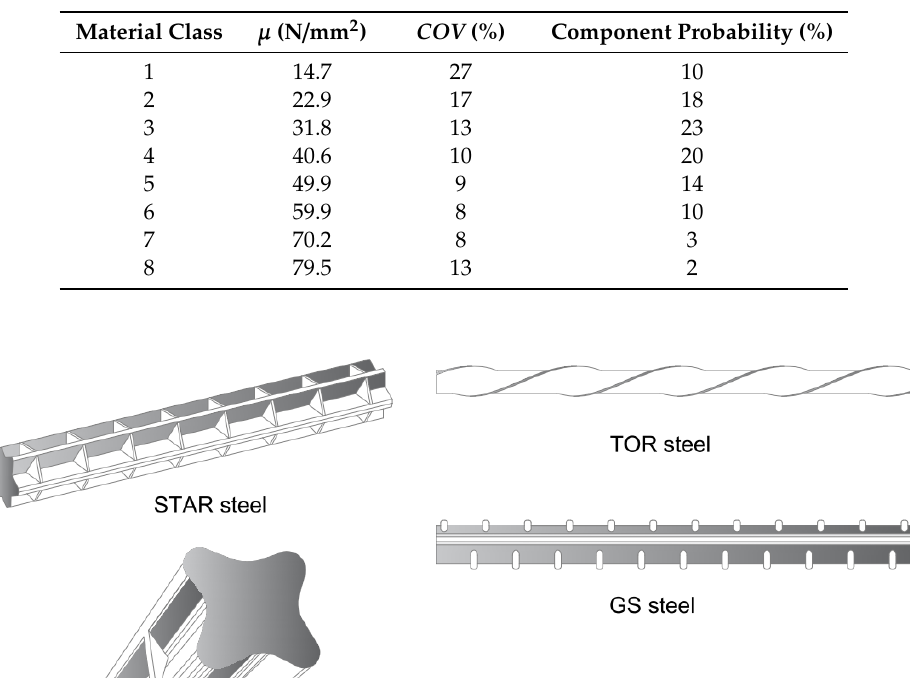
Figure 3. Histogram of yielding strength of main steel rebars used in Italy in 1960s: Aq , high elastic limit steel (known in Italy as ALE), RUMI, GS, STAR and not classified.